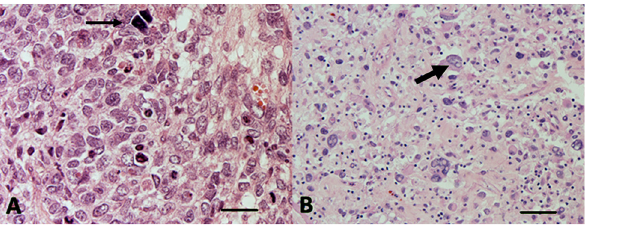
Table 1. Immunohistochemical pattern (according to histotype). Reviewed Diagnosis (with translocation status)